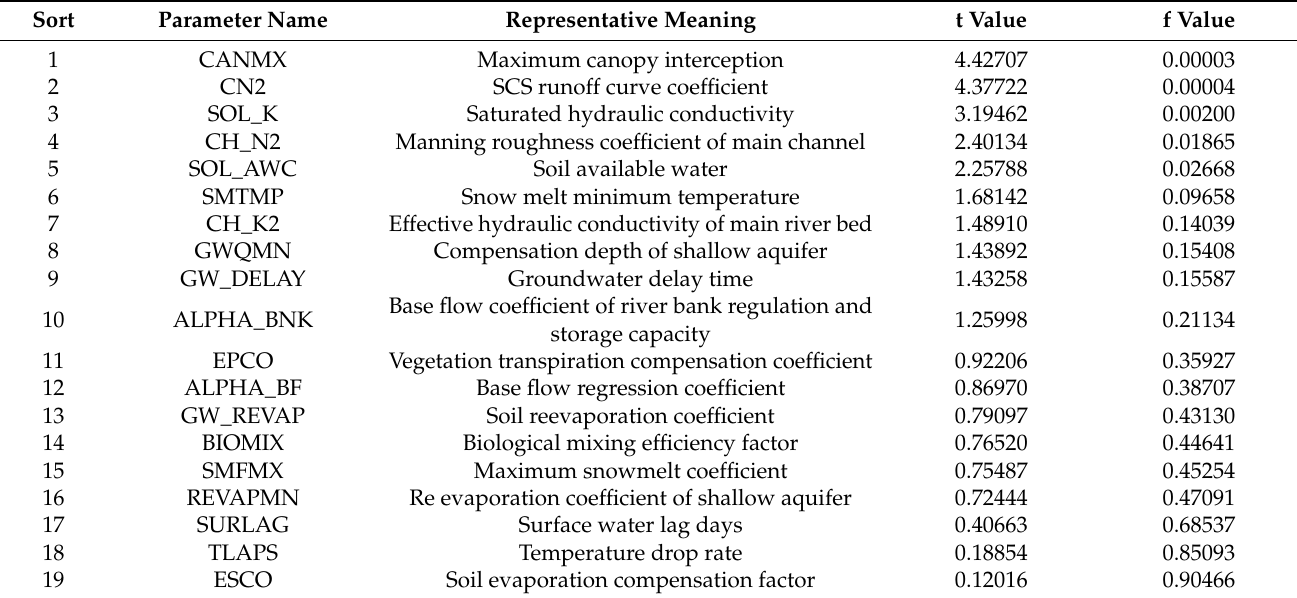
Table 3. Results of parameter sensitivity